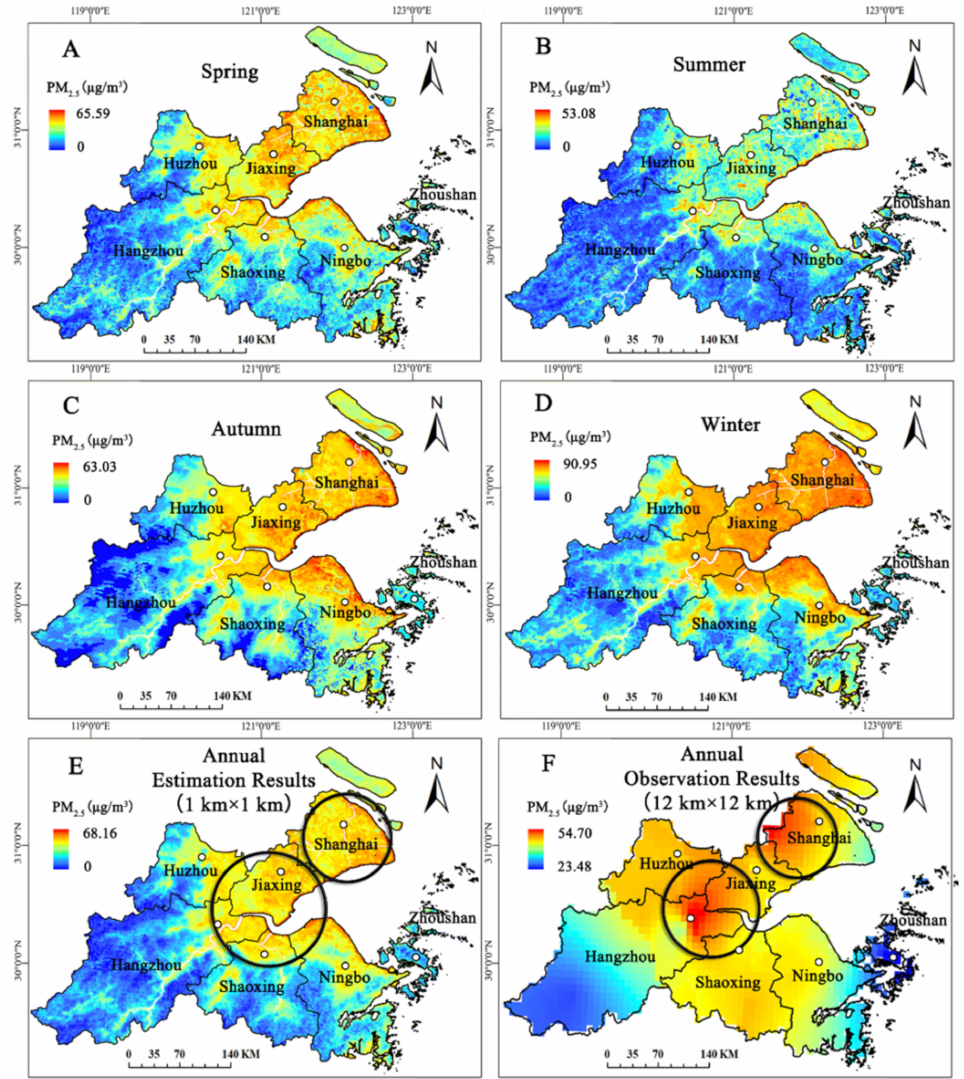
Figure 8. 2016 PM 2.5 concentration maps for SHB. ( A – D ) Seasonal estimates of PM 2.5 concentra- tion. ( E ) Annual average estimates of PM 2.5 concentration (1 km × 1 km). ( F ) Observation PM 2.5 concentration interpolation results (12 km × 12